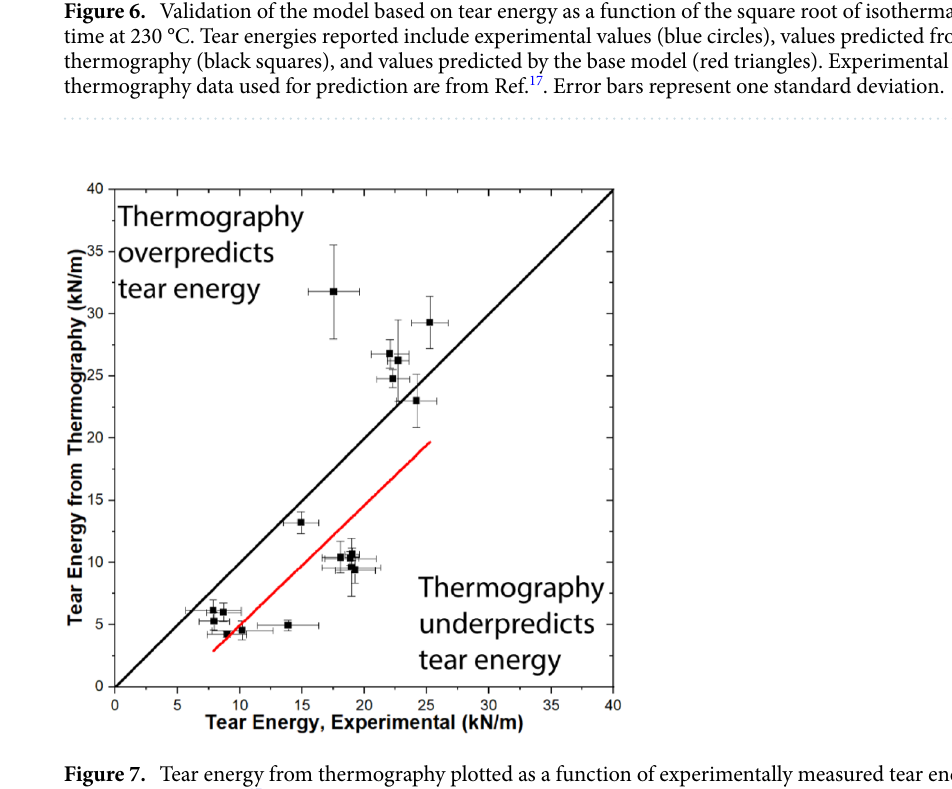
Figure 7. Tear energy from thermography plotted as a function of experimentally measured tear energy. Results are from Ref. 17 . Error bars represent standard